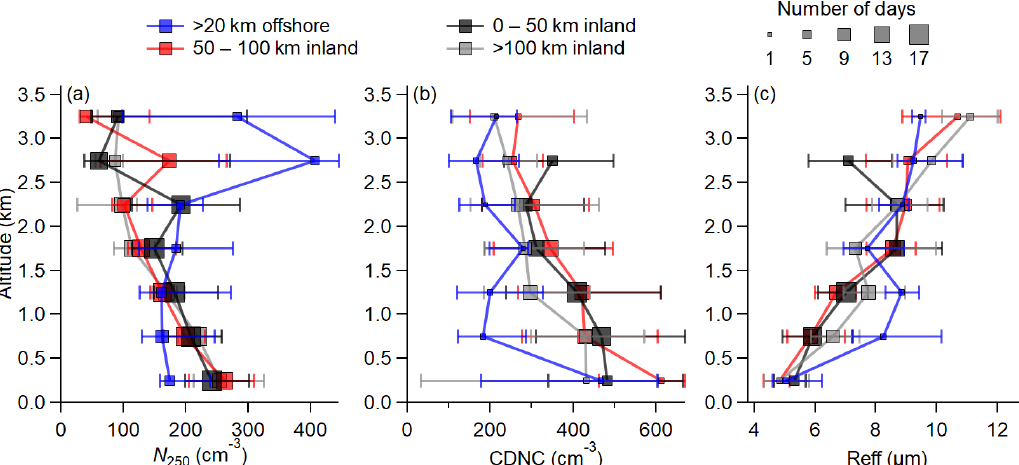
Figure 5. Average vertical profiles of aerosols larger than 250nm (a) , cloud drop number concentration (b) , and effective radius. The markers are the medians and are different sizes depending on the number of individual days the data are taken from. The error bars show the 25th and 75th percentiles, and the solid lines connect the medians. The cloud profiles show the average properties of the cloud field, which often contained multiple discreet